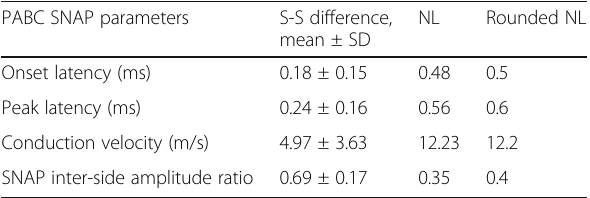
Table 4 Intra-subject side-to-side differences in the posterior antebrachial cutaneous sensory nerve action potential parameters (60 pairs of upper limbs from 60 apparently healthy subjects)